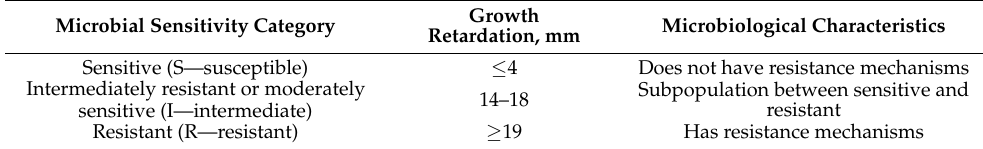
Table 1. Interpretation criteria for the sensitivity of microorganisms of the storage culture of acti- vated sludge. Microbial Sensitivity Category Growth Retardation, mm Microbiological Characteristics Sensitive (S—susceptible) ≤ 4 Does not have resistance mechanisms Intermediately resistant or moderately 14–18 Subpopulation between sensitive and resistant sensitive (I—intermediate) Resistant (R—resistant) ≥ 19 Has resistance